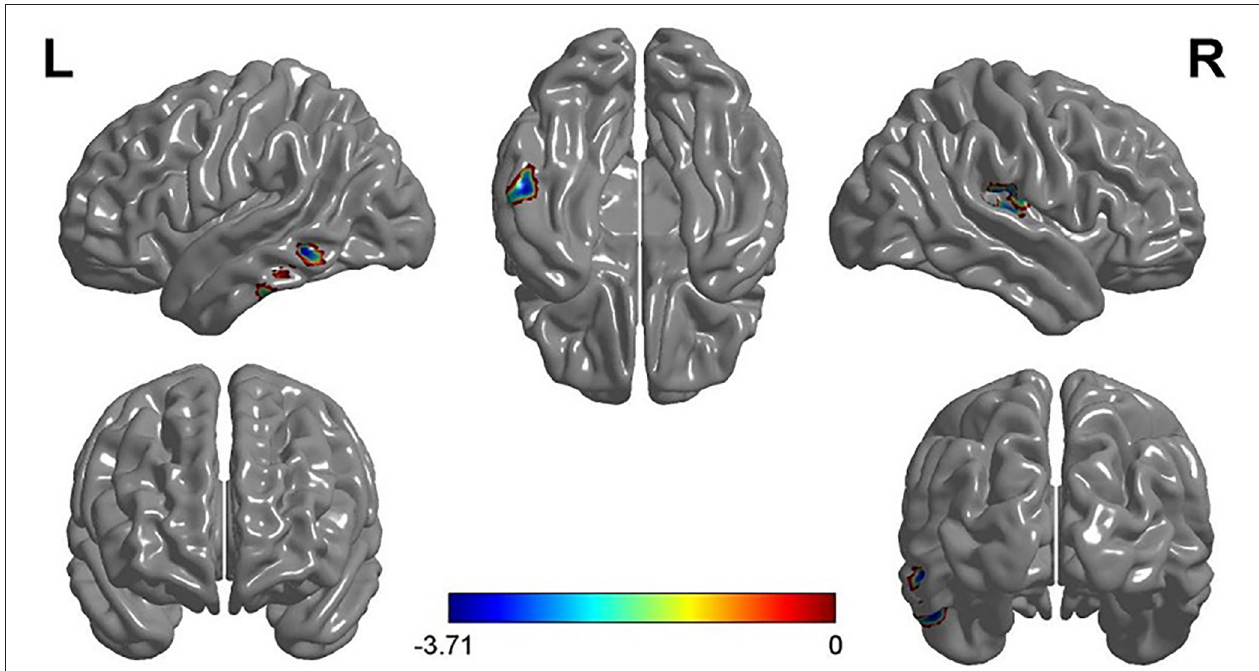
FIGURE 2 | The results of VG vs. FG in the VBM analysis and the gray matter volume (GMV) of the left inferior temporal gyrus and the right superior temporal gyrus of VG were smaller than that of FG. Note: L, left; R, right.